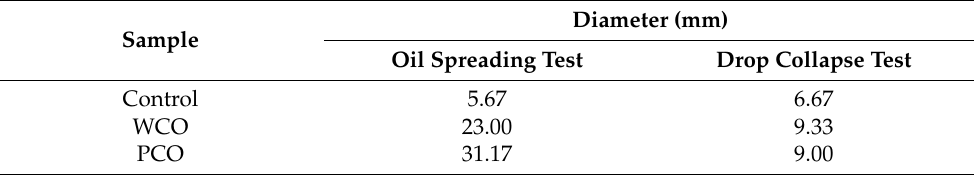
Table 4. Oil spreading and drop collapse test results achieved by BS14 bacterial consortium in WCO and PCO